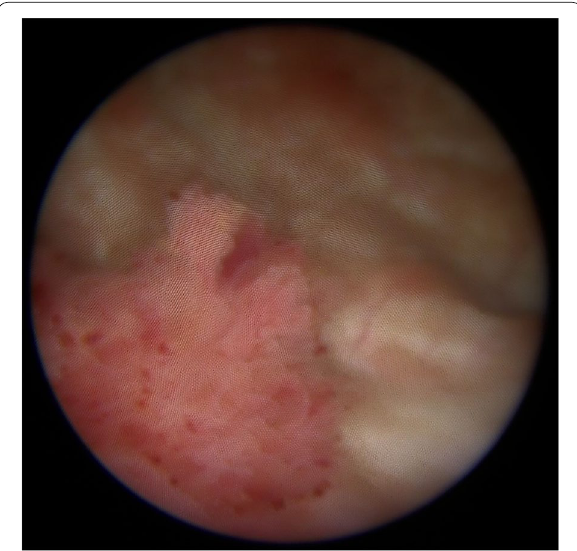
Fig. 1 Cystoscopic view of bladder nephrogenic adenoma on the bladder lateral wall